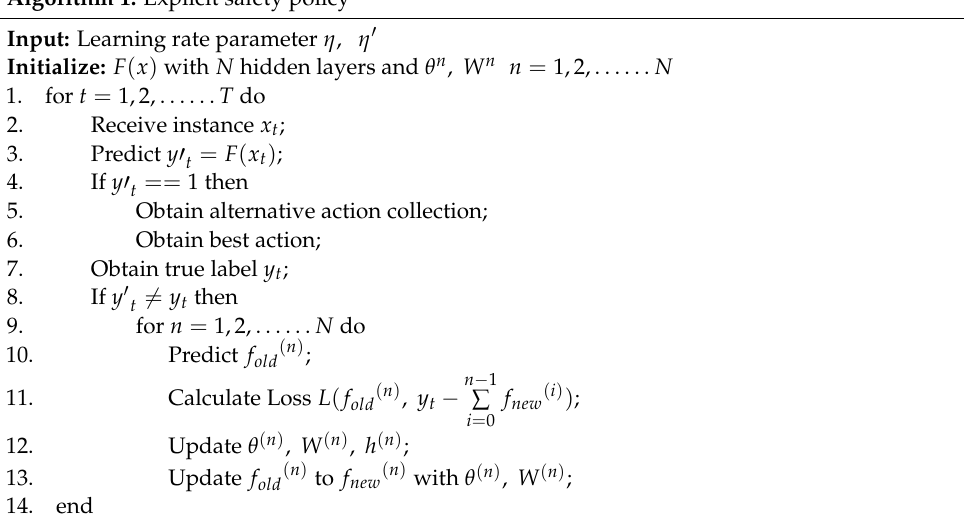
Algorithm 1. Explicit safety policy